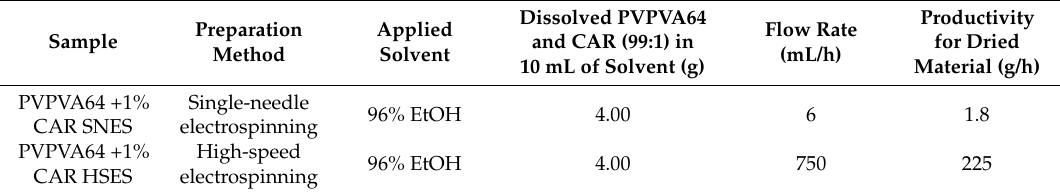
Table 2. Comparison of the details of manufacturing using SNES and